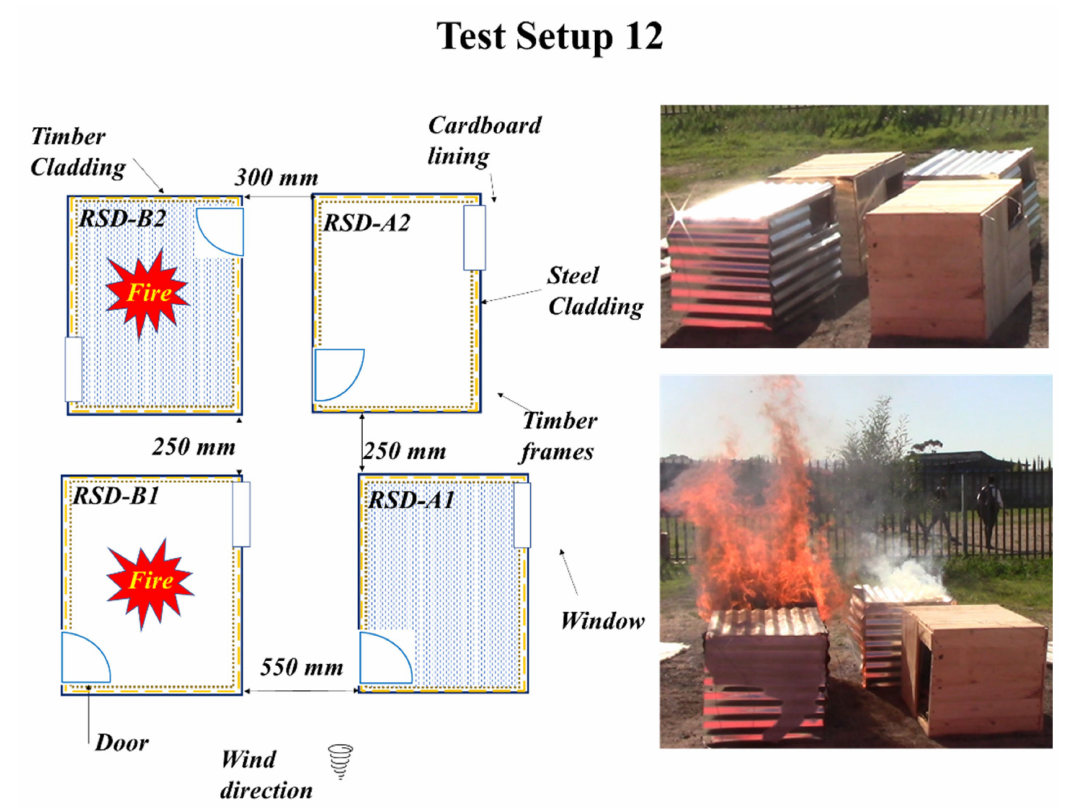
Figure 11. Four RSD experiment: test setup 12; clockwise—schematic view; test setup-11 @ 0